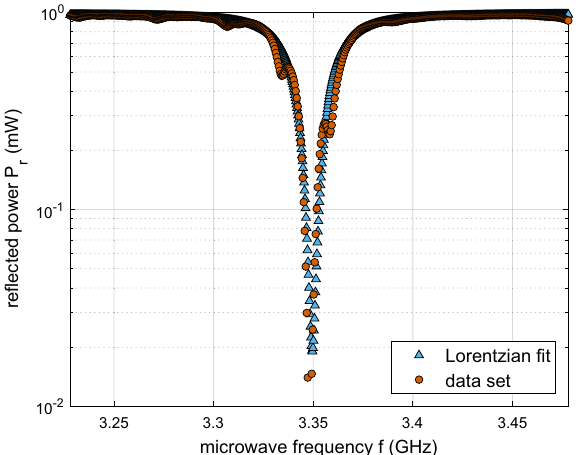
Fig. 3 Typical microwave cavity response to dusty plasma. The spectral response of the microwave cavity is depicted in terms of re fl ected power P r as a function of microwave frequency f , and corresponding Lorentzian fi t, at t = 32.8 s. The Lorentzian fi t is de fi ned by the resonance frequency, at which the re fl ected power is minimal, and the quality factor which is related to the full-width-at-half-maximum of the Lorentzian curve.